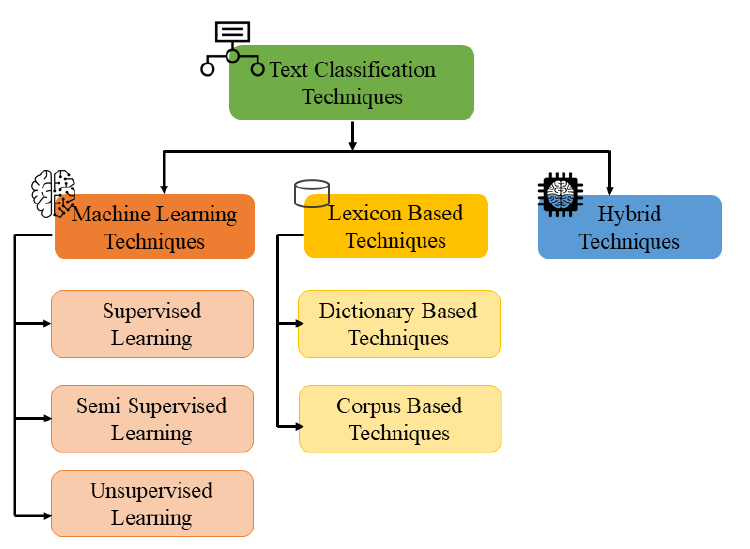
Figure 3. Techniques for Text